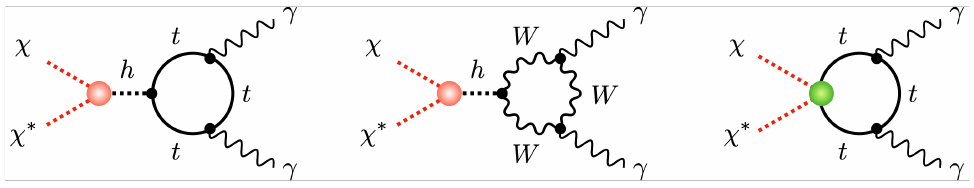
Figure 5 . Example diagrams that lead to the process χ ∗ χ → γγ . Further details can be found in the